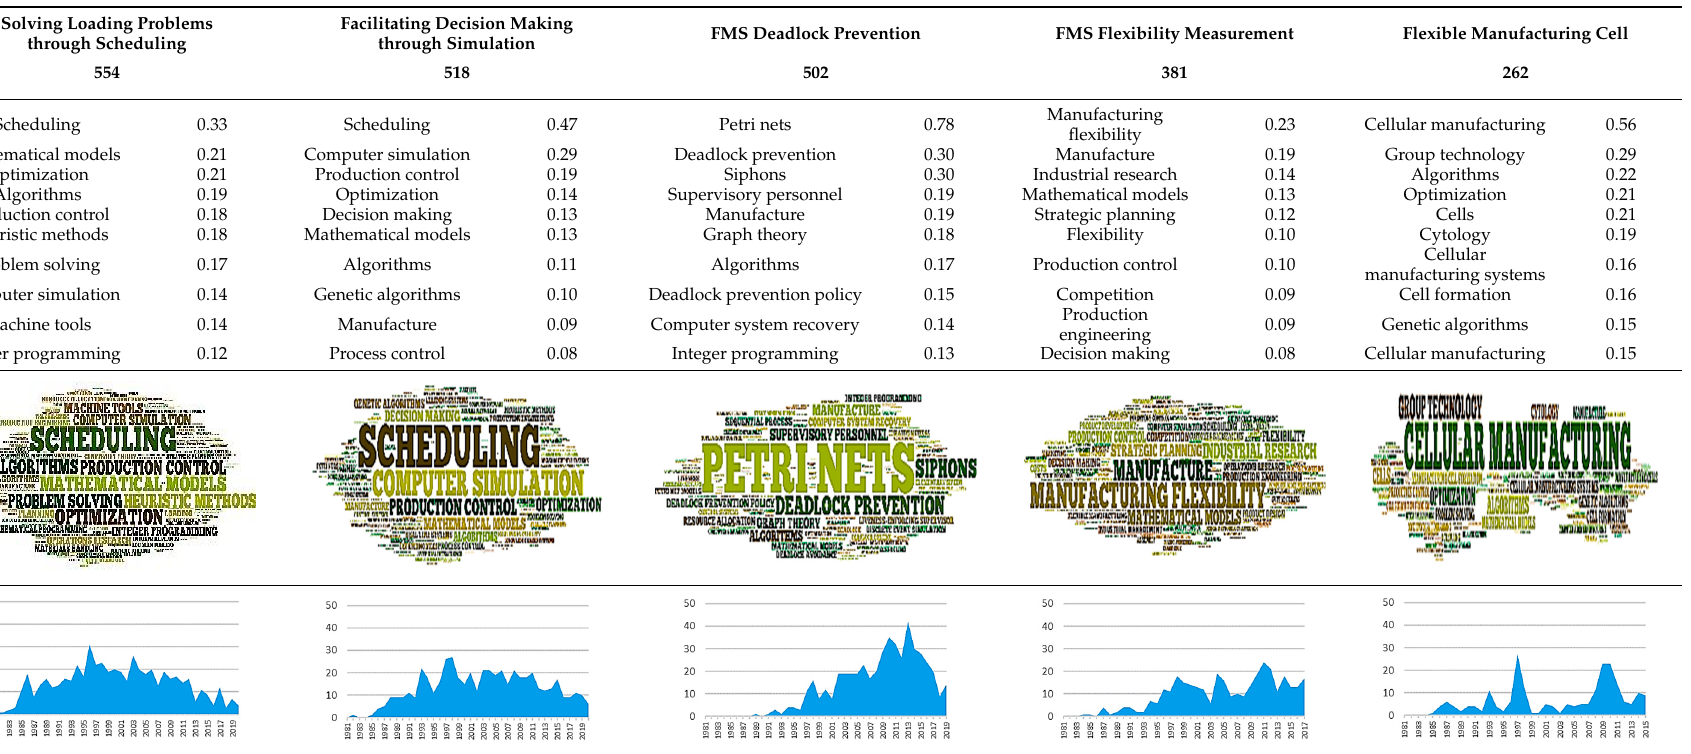
Table 2. Statistics of the top fi ve clusters in cluster analysis.